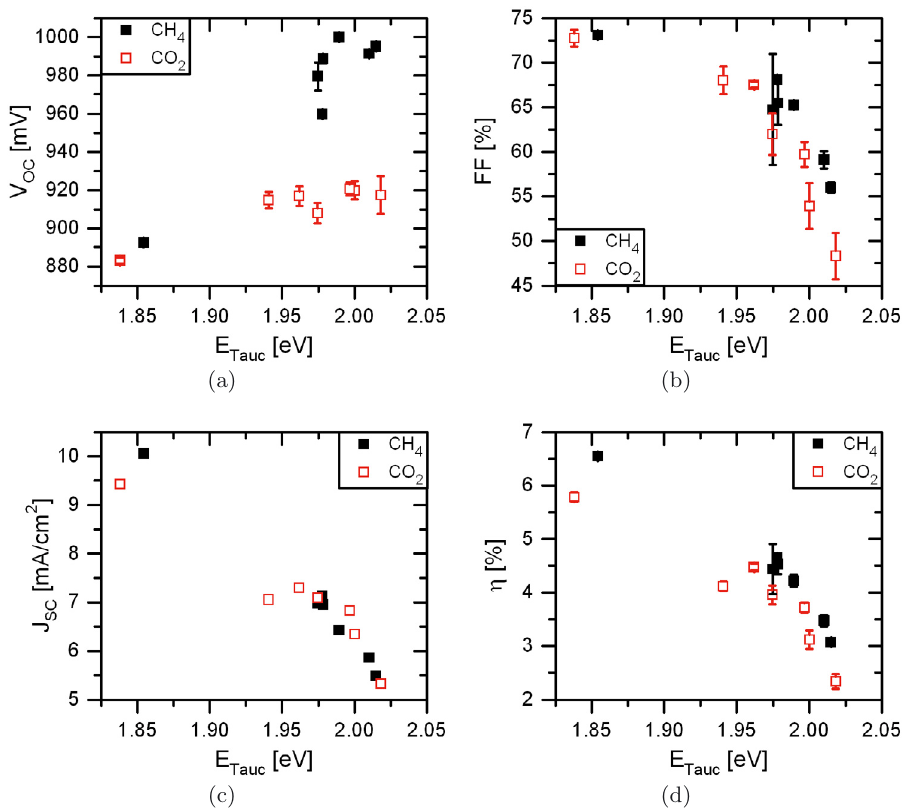
Fig. 2. IV parameters of amorphous silicon alloy single cells produced with CO 2 or CH 4 in the intrinsic layer against Tauc bandgap.